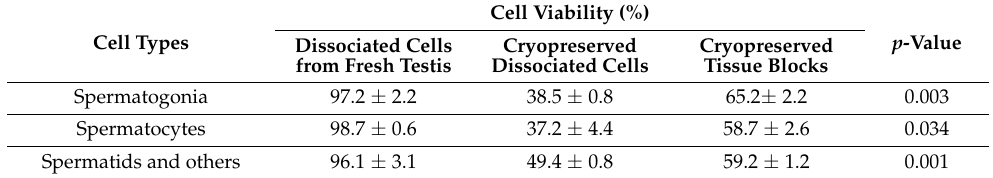
Table 2. The viability of testicular cells from fresh and cryopreserved testis from 2-year-old shad.